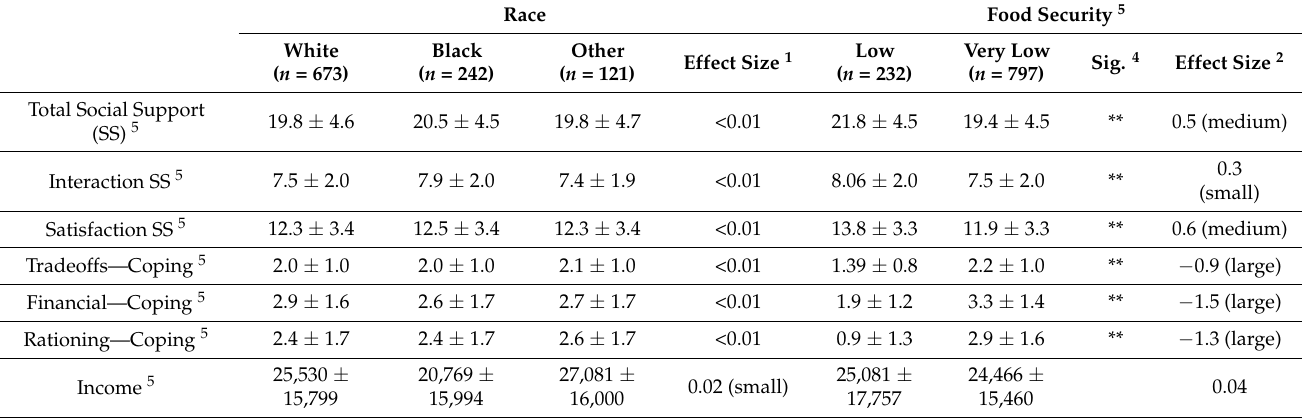
Table 3. Linear regression of social support, food coping strategies, and mental health by race and food security status for food-insecure mothers in Virginia ( n =